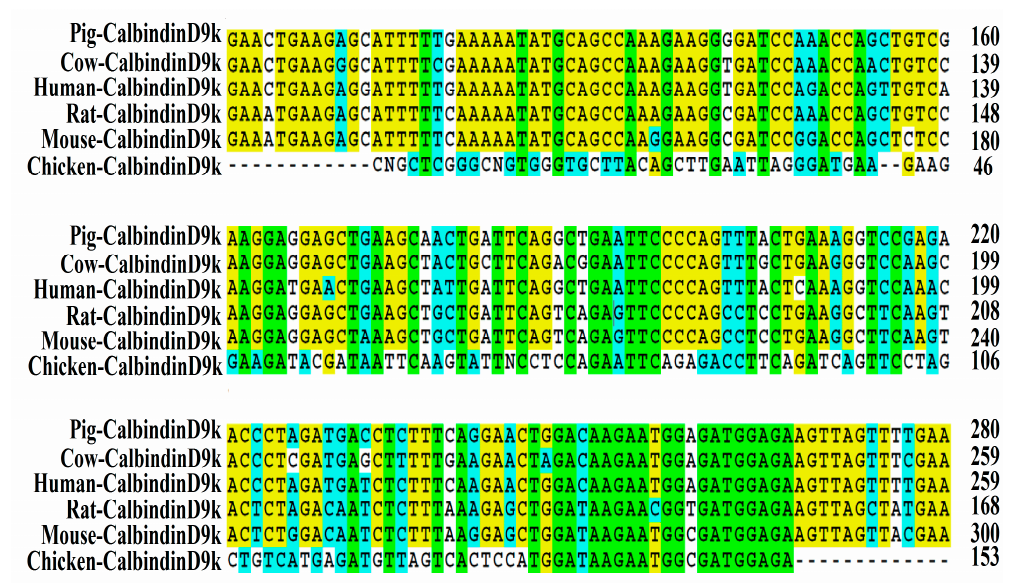
Figure 1. Predicted partial amino acid sequences of the chicken intestinal CalbindinD9k (Ca transporter D9k) exporter. The alignment of predicted amino acid sequences of chicken intestinal CalbindinD9k with pig CalbindinD9k (GI397265), cow CalbindinD9k (GI281658), human CalbindinD9k (GI65795), mouse CalbindinD9k (GI12309) and rat CalbindinD9k (GI24249) is shown. Homologous residues are